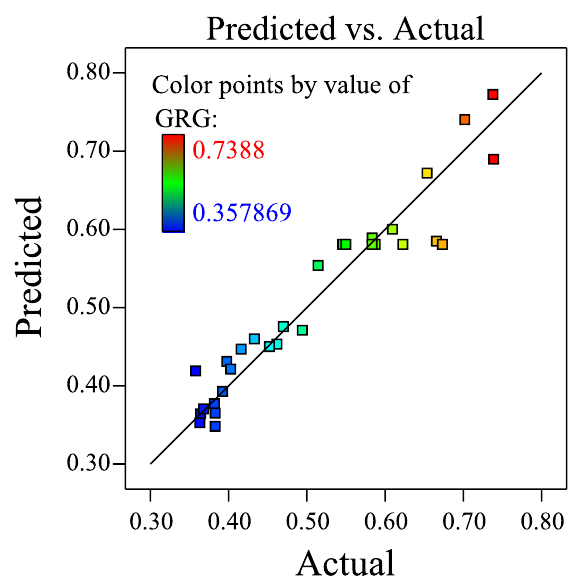
Figure 5. Actual and predicted GRG values.